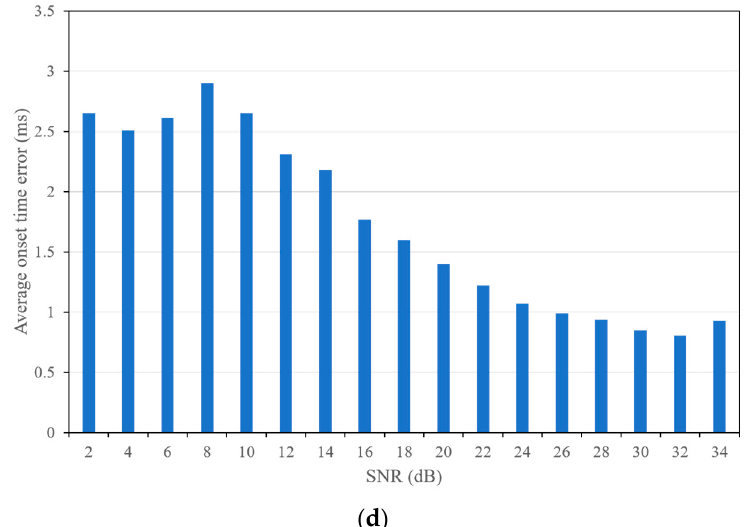
Figure 4. ( a ) Visualization of denoising and detection performance of PDTN in the Grand Canyon tunnel data set. It consists of three graphs: from top to bottom, noisy signal, denoised signal, and manual and predicted durations, respectively. ( b ) Error distribution diagram of manual and PDTN onset time picking of noisy signals. ( c ) SNR layout before and after PDTN denoising. ( d ) The relation between SNR of noise signal and onset time error.